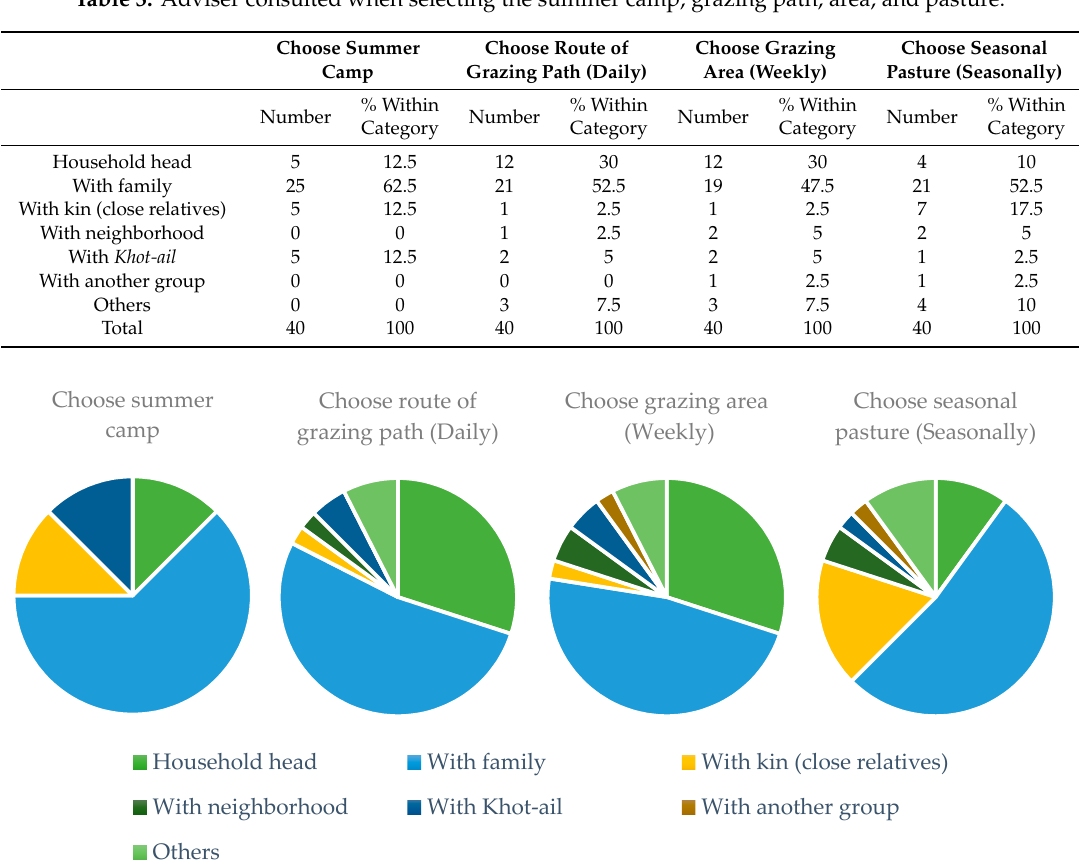
Table 3. Adviser consulted when selecting the summer camp, grazing path, area, and pasture. Choose Summer Choose Route of Camp Grazing Path (Daily)